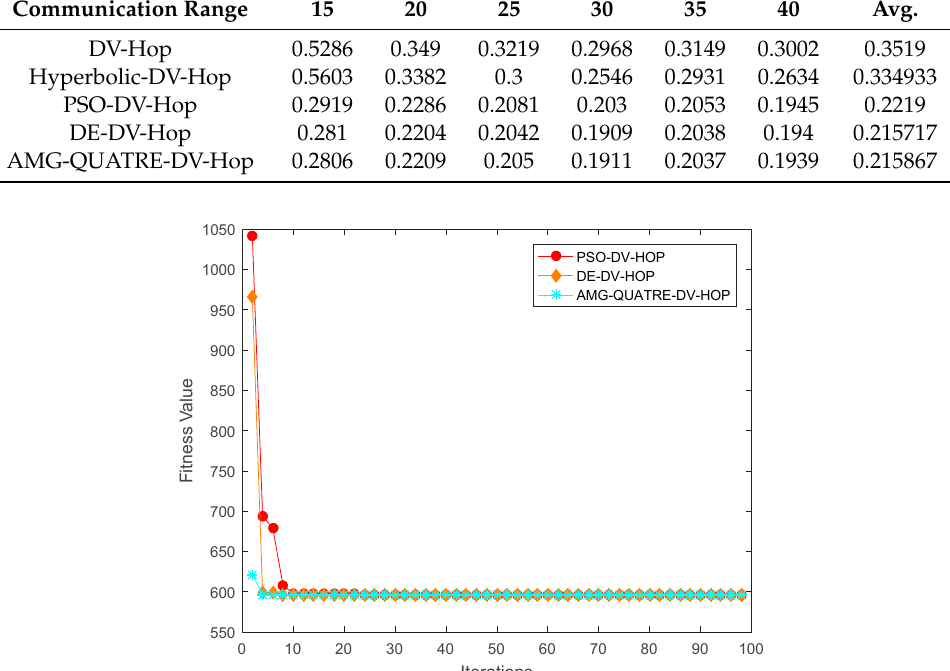
Figure 9. Comparison of location errors of the applied AMG-QUATRE with the other methods for a different communication range.